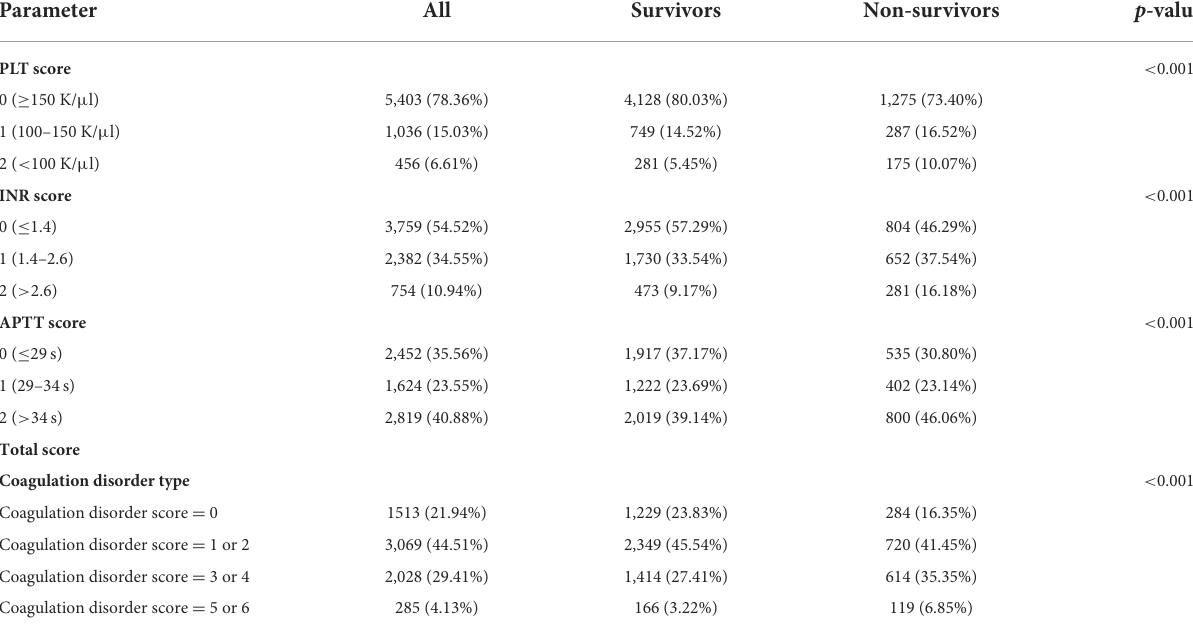
TABLE 2 Comparisons of the abnormalities of PLT, INR, and APTT between survivor and non-survivor groups. Parameter